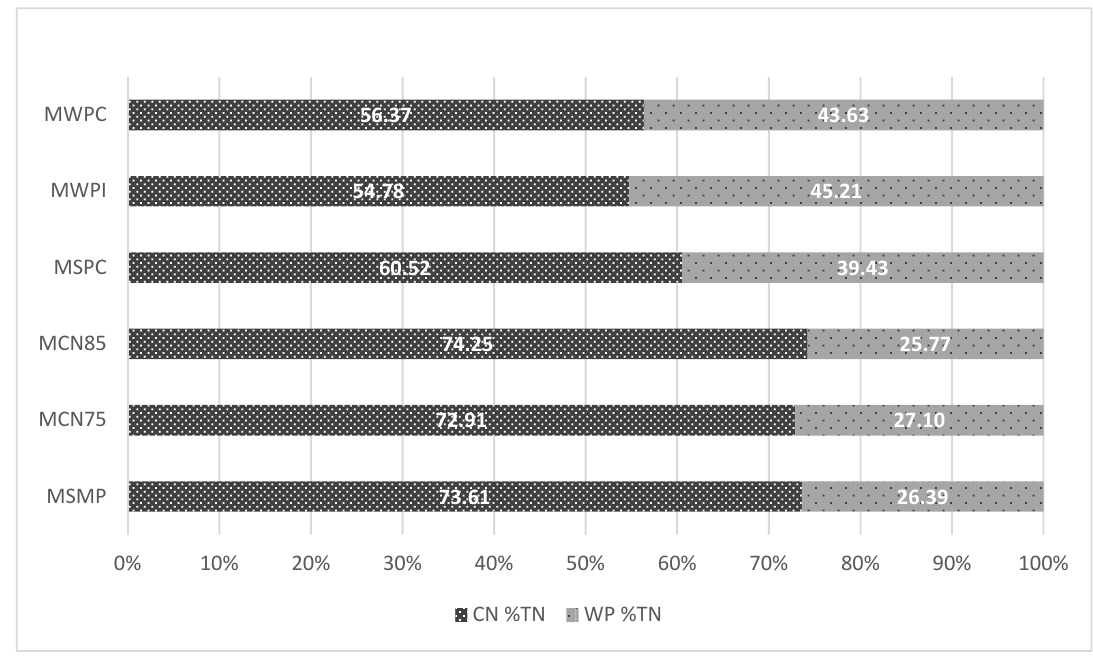
Figure 3. Average content of casein and whey proteins in a densitometric analysis of electrophoreto- grams ( n = 2). CN—casein; WP—whey protein; TN—total nitrogen; MSMP—milk with skim milk powder, control sample; MCN75—milk with micellar casein concentrate with 75% protein content; MCN85—milk with micellar casein concentrate with 85% protein content; MSPC—milk with serum protein; MWPI—milk with whey protein isolate; MWPC—milk with whey protein concentrate.